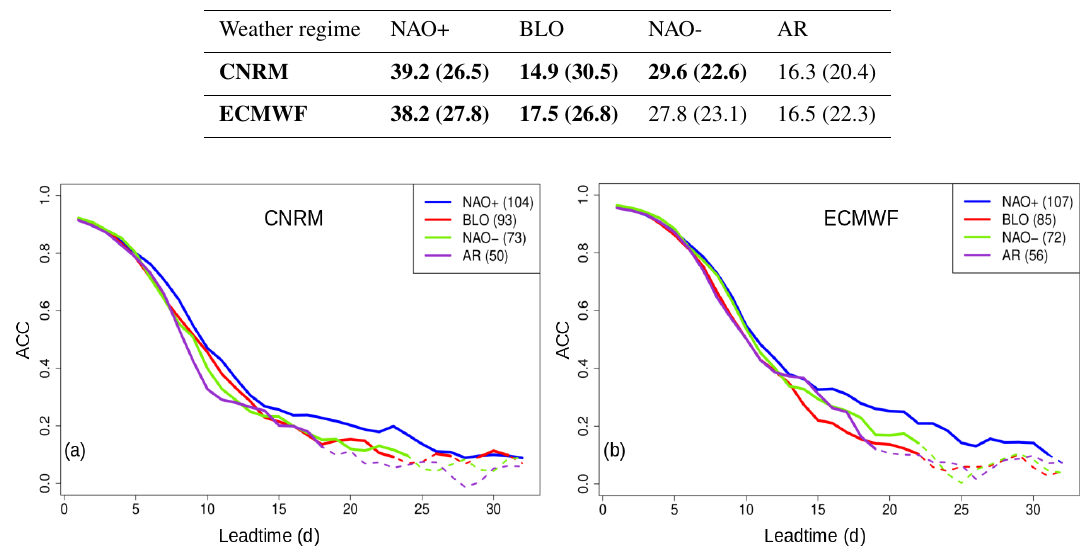
Figure 5. Mean ACC evolution with forecast time over Europe by initial weather regime for (a) CNRM and (b) ECMWF. Solid lines indicate values significantly positive at the 99% confidence level. The number of forecasts for each initial regime is reported in